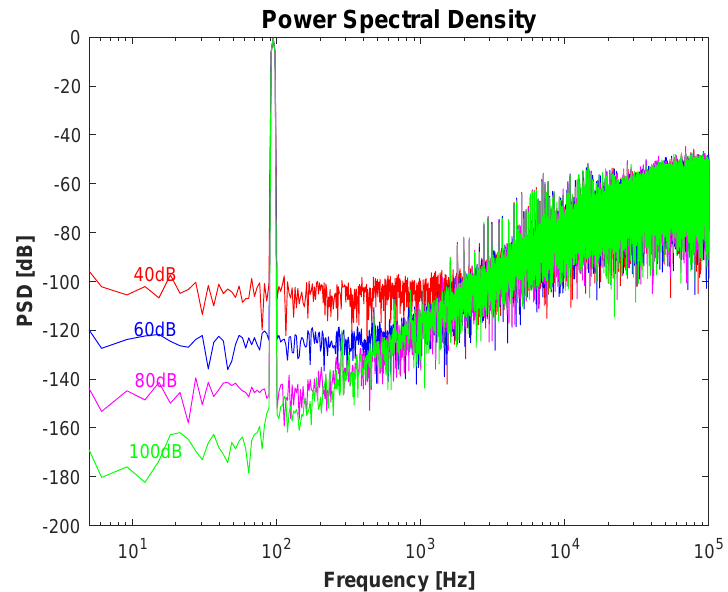
Figure 5. Effect of amplifier’s DC gain and its nonlinearity on zoom ADC